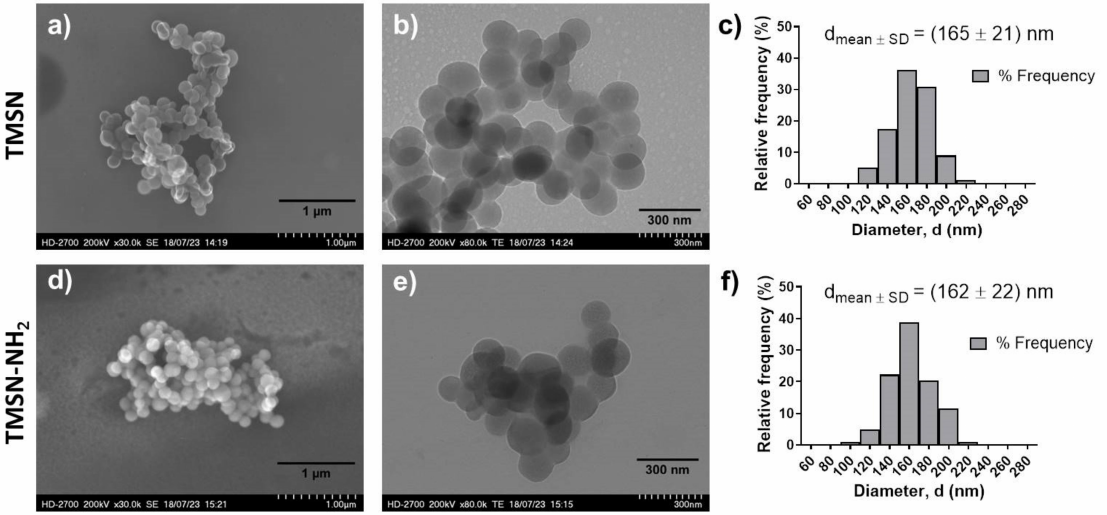
Figure 1. Morphology and size distribution of TMSNs ( a – c ) and TMSNs-NH 2 ( d – f ). SEM (( a , d ), scale bar = 1 µ m) and TEM (( b , e ), scale bar = 300 nm) images of TMSNs ( a , b ) and TMSNs-NH 2 ( d , e ); and histograms showing the particle size distribution measured from the images of TMSNs (( c ), n = 155) and TMSNs-NH 2 (( f ), n =